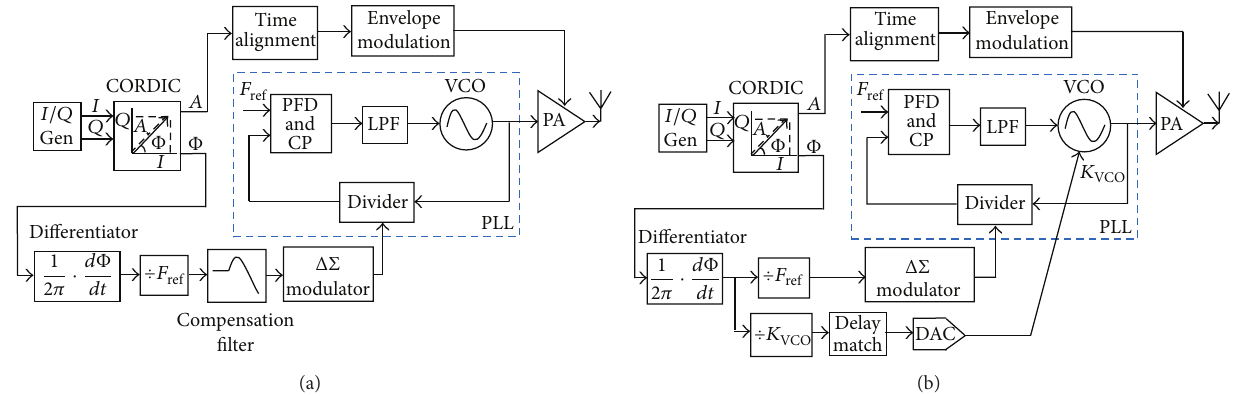
Figure 1: Polar transmitters with ΔΣ PLL based phase modulation: (a) digital precompensation and (b) two-point modulation techniques.